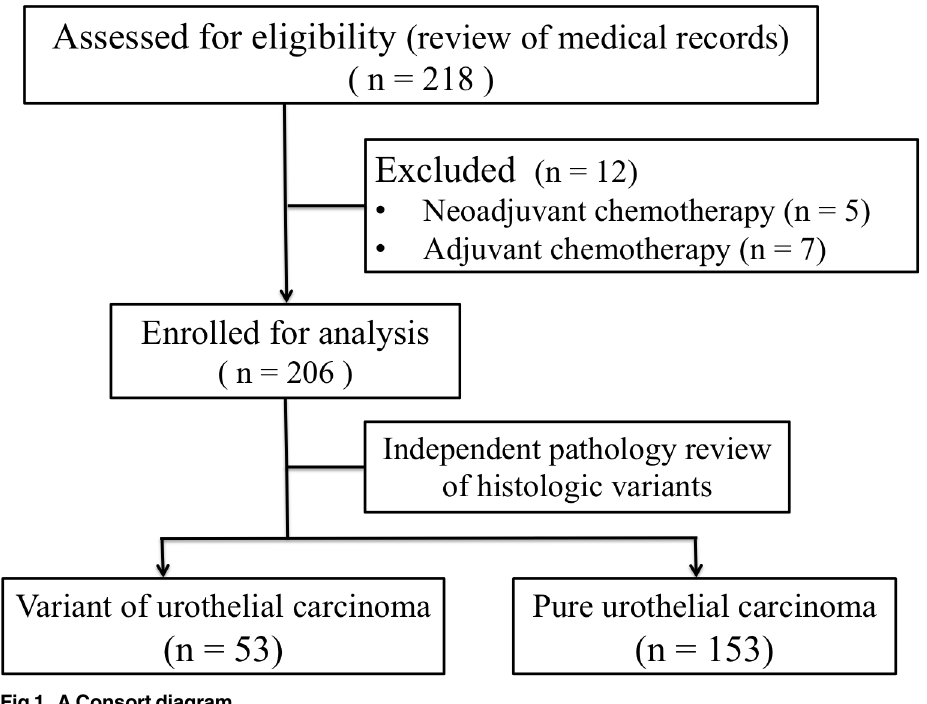
Fig 1. A Consort diagram.